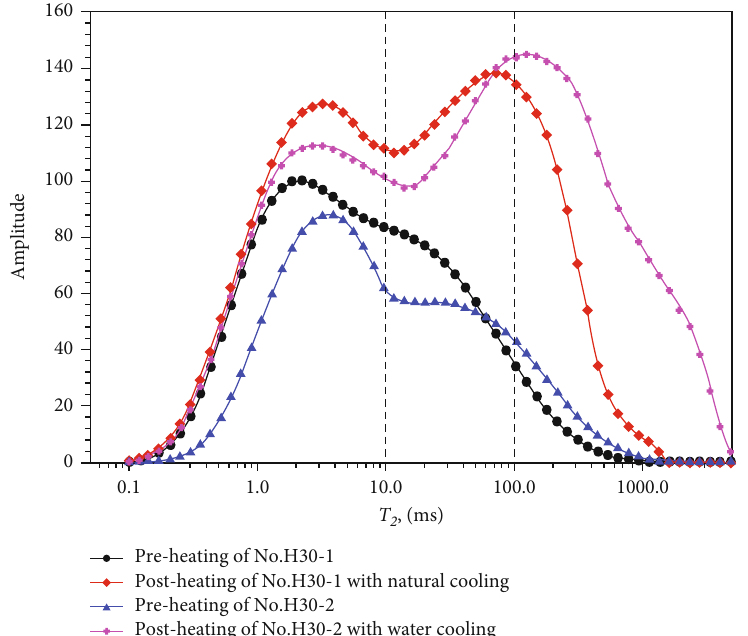
Figure 13: T spectrums and pore size distribution of the core samples (No. H30-1 and No. H30-2) at 800 ° C under two di ff erent cooling 2 methods.